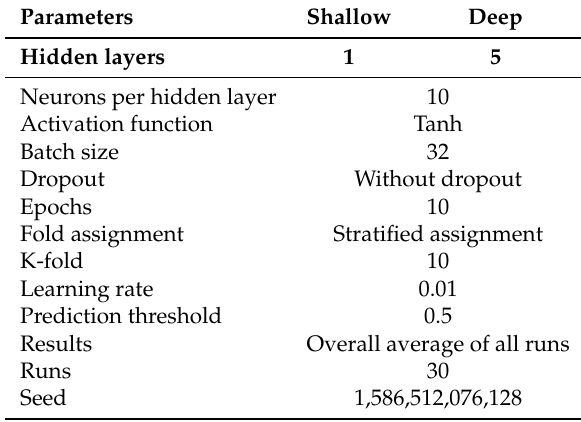
Table 4. Configuration parameters for shallow and deep ANN